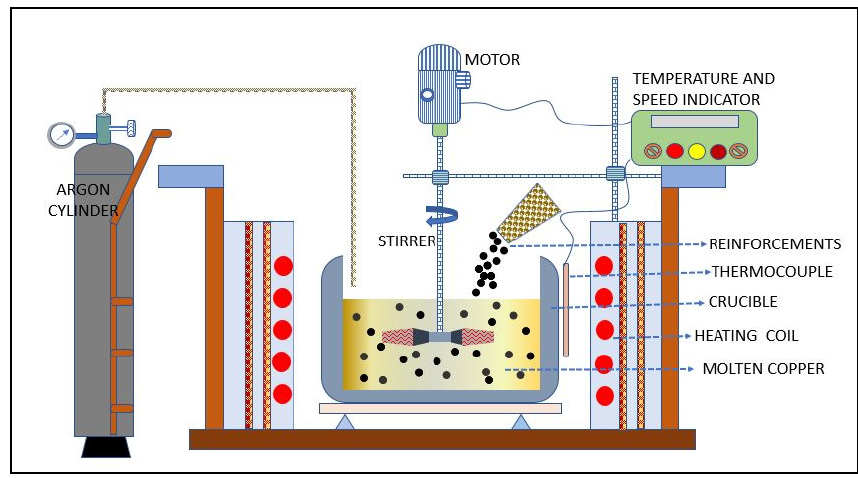
Figure 1. Schematic representation of the stir casting setup for composite synthesis. Table 3. Compositions of the fabricated MMC.